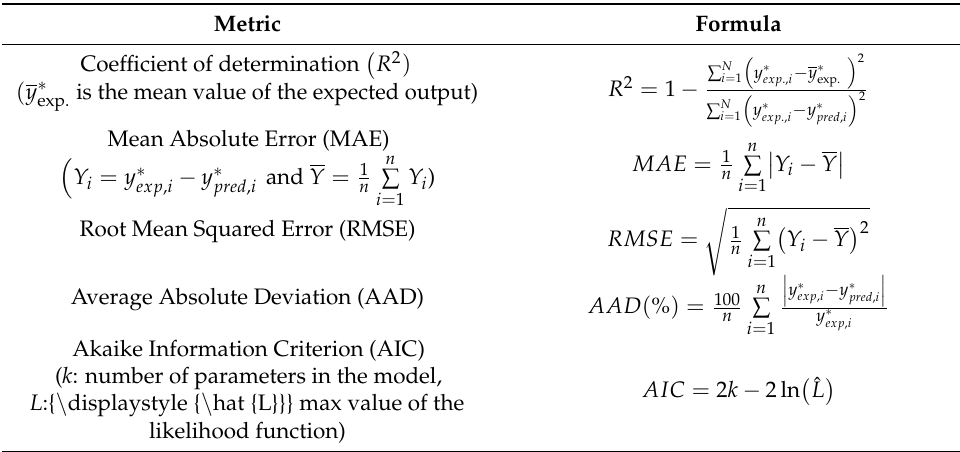
Table 5. Metrics used to characterize a method’s accuracy. Metric